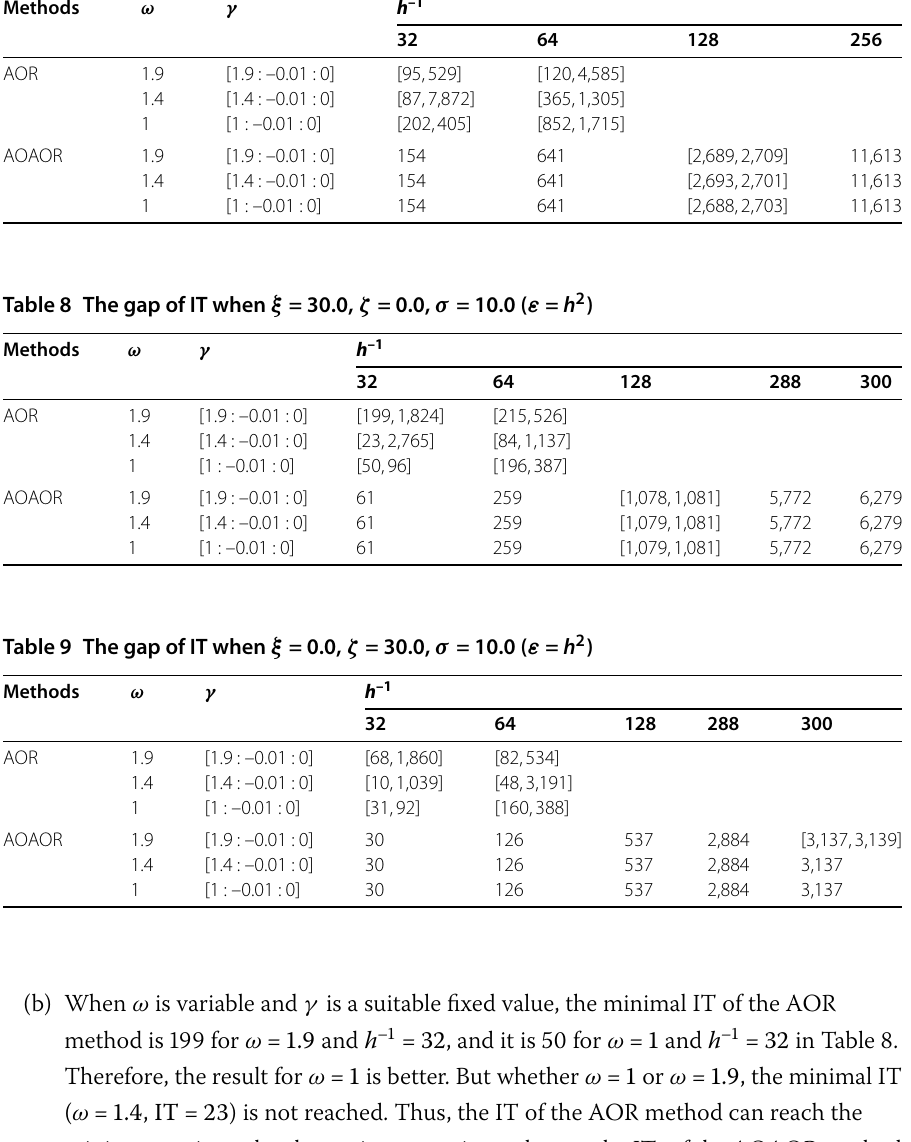
Table 7 The gap of IT when ξ = ζ = 0.0, σ = 2.5 ( ε = h 2 /5) Methods